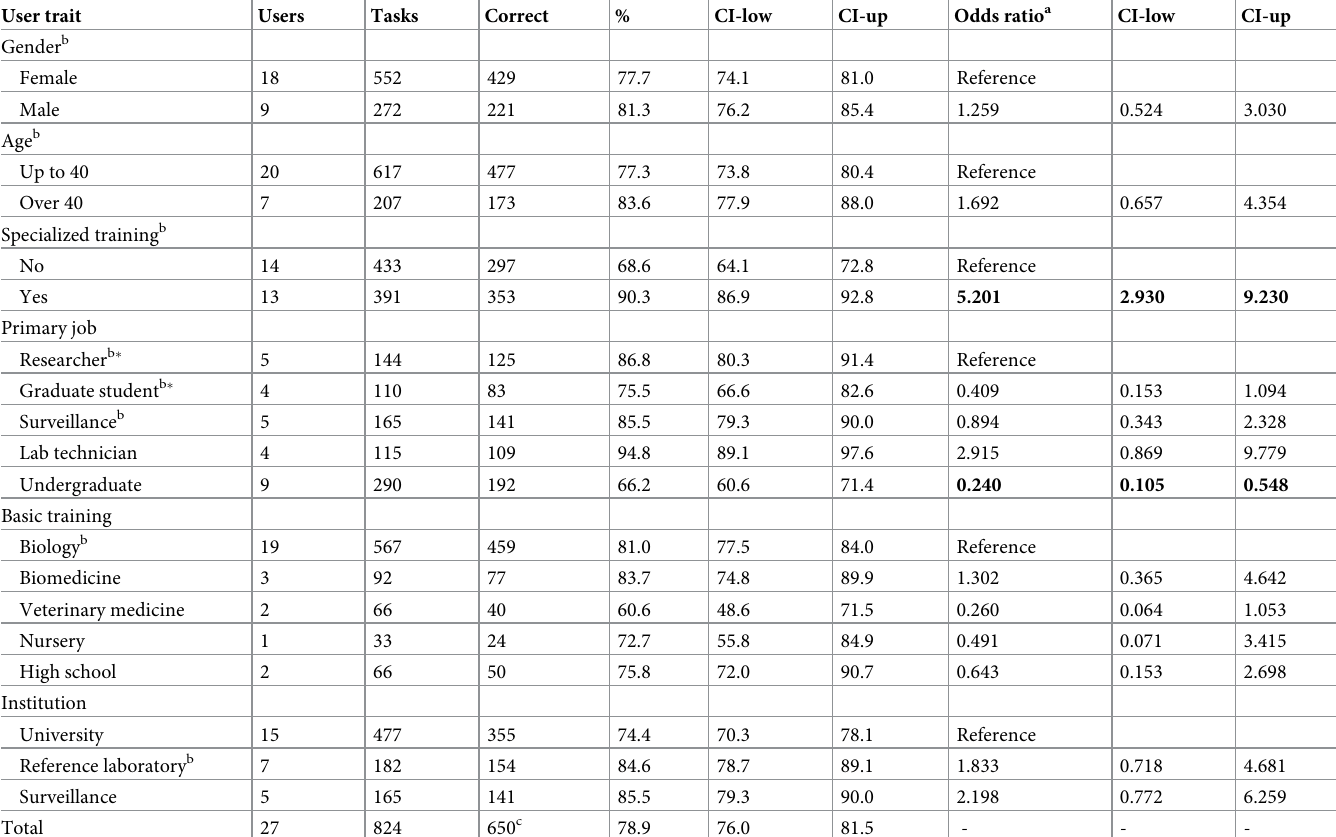
Table 4. T RIATO D EX performance across user traits: Descriptive results and exploratory data analyses.